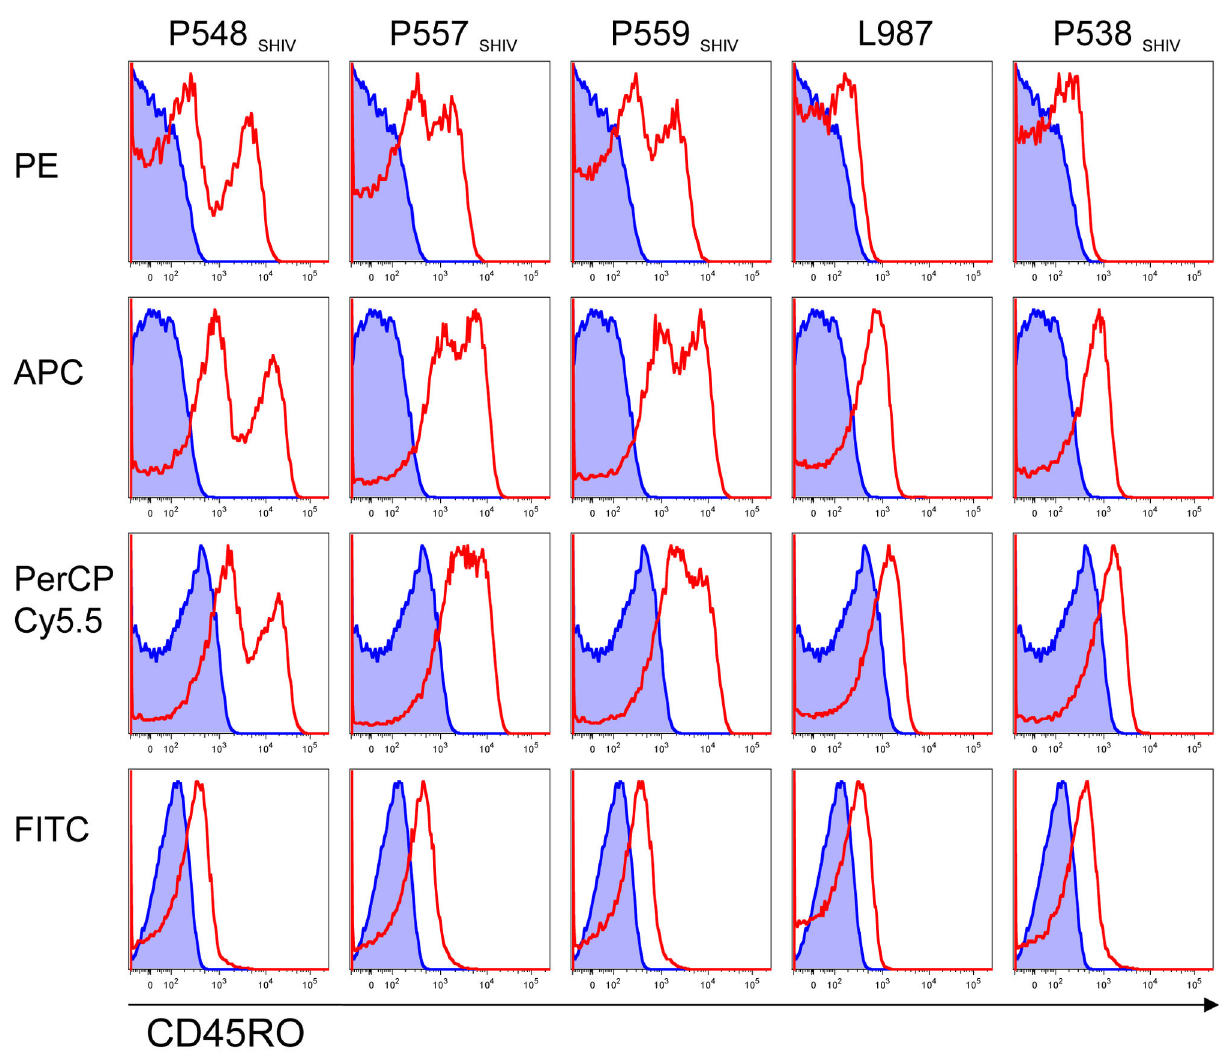
Figure 3. Binding of directly conjugated UCHL1 to lymphocytes from rhesus macaques. Direct immunofluorescence was performed on freshly isolated PBMC from four SHIV-infected and one uninfected rhesus macaques. UCHL1 conjugated to PE, APC, PerCP Cy5.5, or FITC and Ab to CD3, CD4 and CD8 were used. Fluors used in each panel were adjusted to accommodate the fluor on UCHL1. Cells were gated on singlets and lymphocytes by light scatter, and then on CD3+ CD4+ cells. FMO controls are shown in